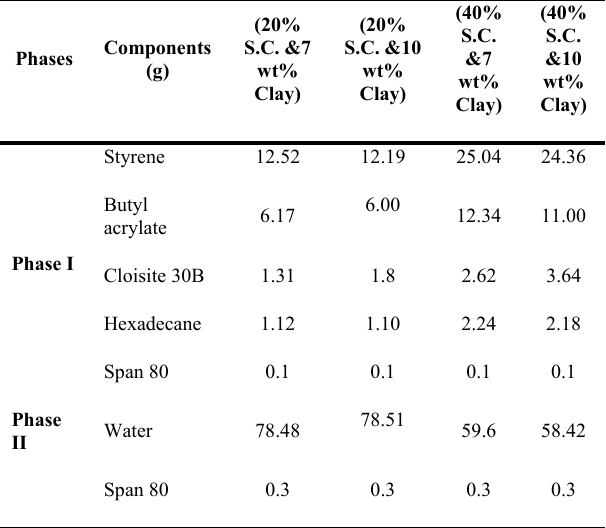
Table 1. Miniemulsion recipe of poly